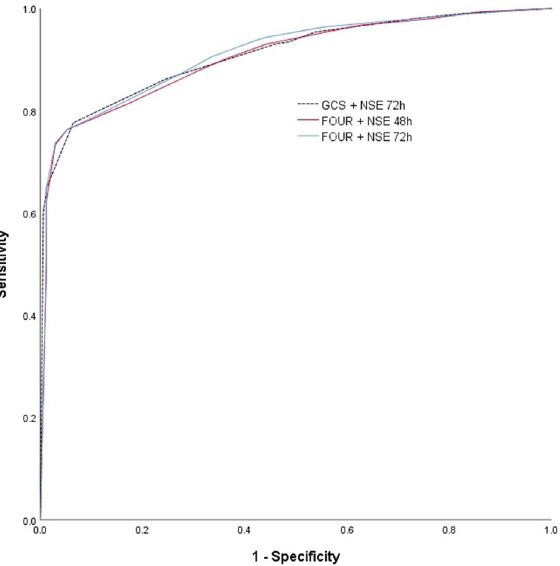
Figure 2. Comparison of the receiver operating characteristic curves in combinations of categorized predictors. AUC for the combination of categorized FOUR score and categorized NSE 72 h: 0.912 (criteria > 11, sensitivity = 76.3%, specificity = 94.7%); for the combination of categorized FOUR score and categorized NSE 48 h: 0.906 (criteria > 11, sensitivity = 76.3%, specificity = 94.7%); and for the combination of categorized GCS score and categorized NSE 72 h: 0.910 (criteria > 10, sensitivity = 77.6%, specificity = 93.6%). Comparison of ROC curves with Bonferroni correction: FOUR + NSE 72 h vs. FOUR + NSE 48 h, p = 0.453; FOUR + NSE 72